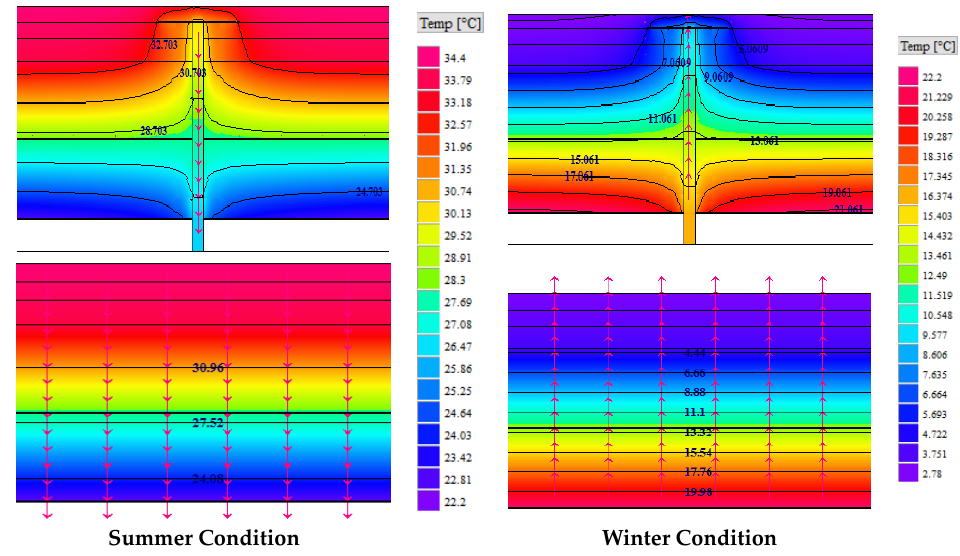
Figure 4. Comparison between the cases of “with fasteners” (first row) and “without fasteners” (second row) using isotherms and the Heat Flow direction, in case of 1A Orlando Summer and Winter Conditions.